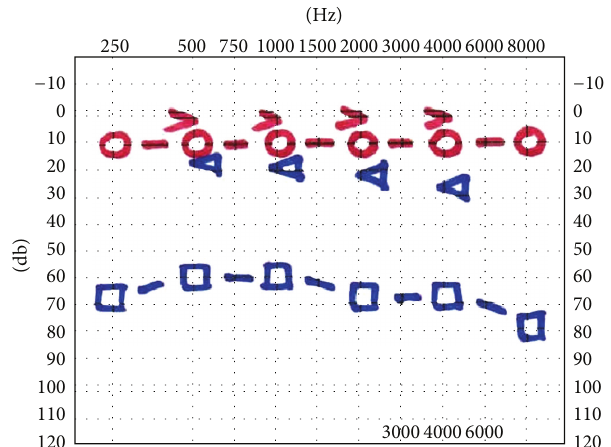
Figure 6: At 36-month follow-up a pure-tone audiometry identifies any worsening of hearing loss.